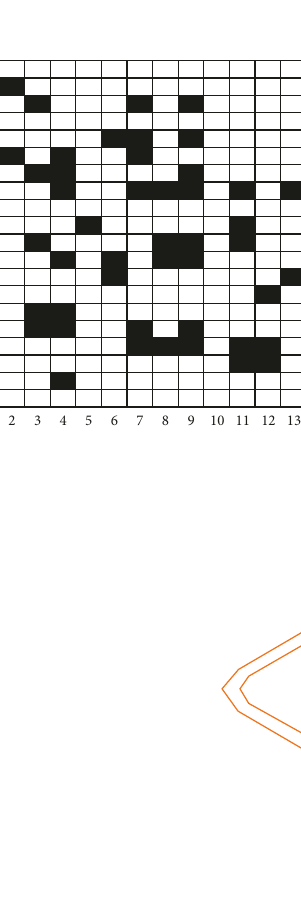
Figure 3: “Double bridge” experiment of ant colony